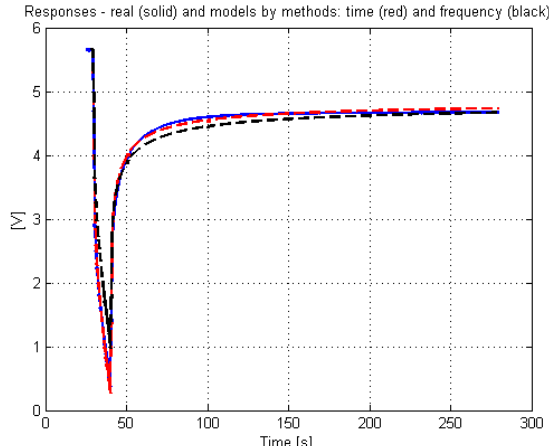
Figure 11. The trapezoidal current pulse and the initial phase of voltage response of SC of 0.47 F capacitance (red line).